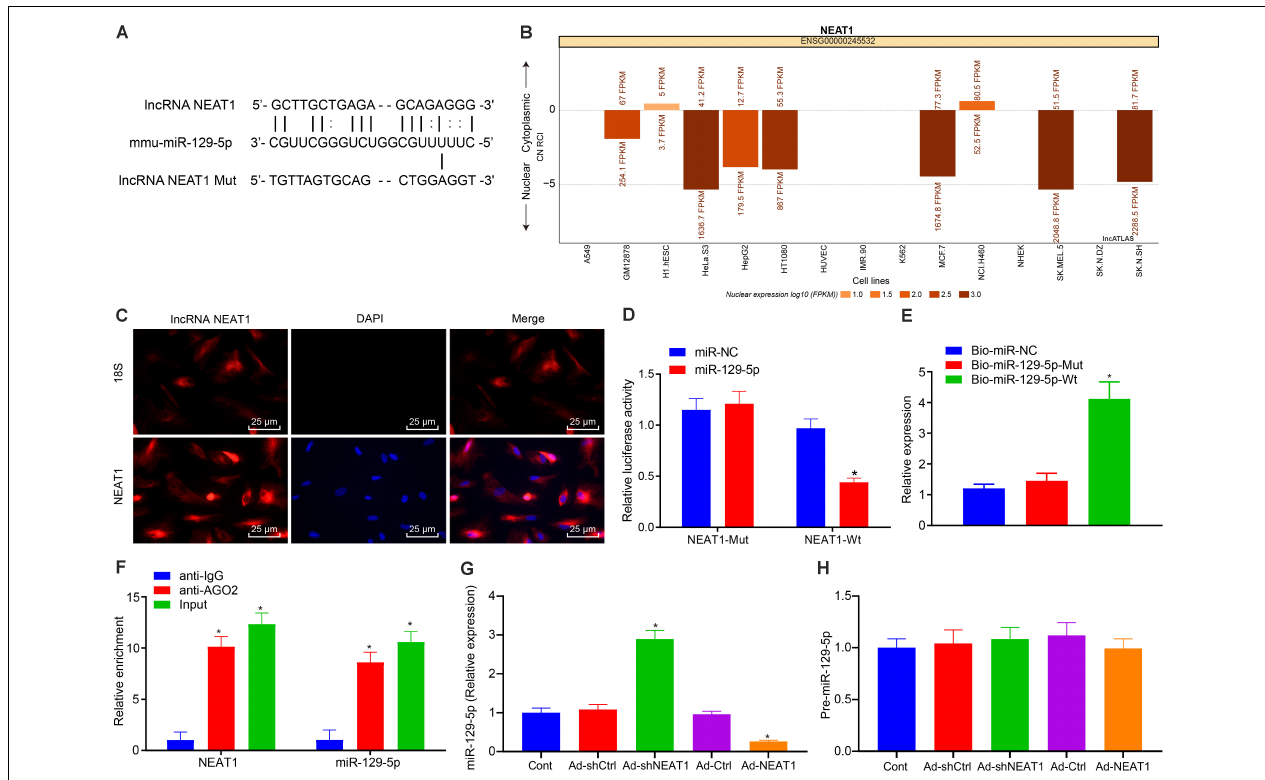
FIGURE 6 | NEAT1 binds to miR-129-5p for regulation of PEG3 expression. (A) Binding sequences between NEAT1 and miR-129-5p. (B) Subcellular localization of NEAT1 analyzed on http://lncatlas.crg.eu/. (C) Subcellular localization of NEAT1 detected by FISH ( × 400). (D) Relative luciferase activity of NEAT1 WT 3 (cid:48) UTR or NEAT1 MUT 3 (cid:48) UTR. (E) Relative expression of NEAT1 in the presence of Bio-miR-129-5p-Mut or Bio-miR-129-5p-Wt detected by RNA pull-down. (F) Relative enrichment of Ago2 caused by NEAT1 and miR-129-5p detected by RIP assay. (G) The expression of miR-129-5p in each group detected by qRT-PCR. (H) The expression of precursor miR-129-5p in each group detected by qRT-PCR. * p < 0.05 vs. the miR-NC or Bio-miR-NC or anti-IgG group (cells in the presence of miR-NC or Bio-miR-NC or anti-IgG). All data were measurement data and expressed as mean ± standard deviation. One-way analysis of variance was used for data comparison among multiple groups. The experiment was independently repeated three times. N = 6. NEAT1, nuclear enriched abundant transcript 1; FISH, fluorescence in situ hybridization; Mut, mutant; Wt, wild-type; Ago2, Argonaute2; RIP, RNA immunoprecipitation; IgG, immunoglobulin G.